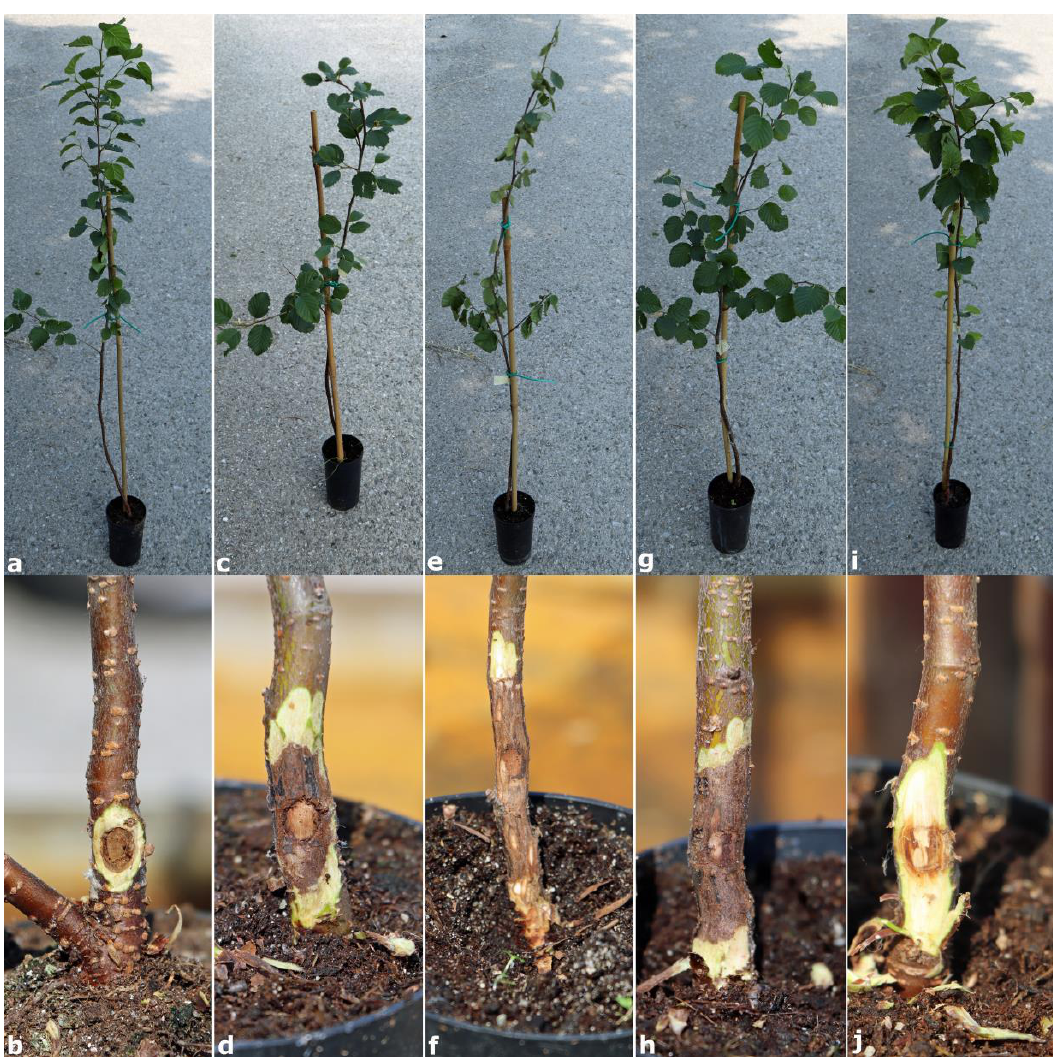
Figure 5. Symptoms observed on green alder seedlings 30 days after inoculation with Phytophthora alpina ( a , b ), Phytophthora pseudocryptogea ( c , d ), Phytophthora pseudosyringae ( e , f ) and Phytophthora × serendipita ( g , h ). Control seedlings ( i , j ).